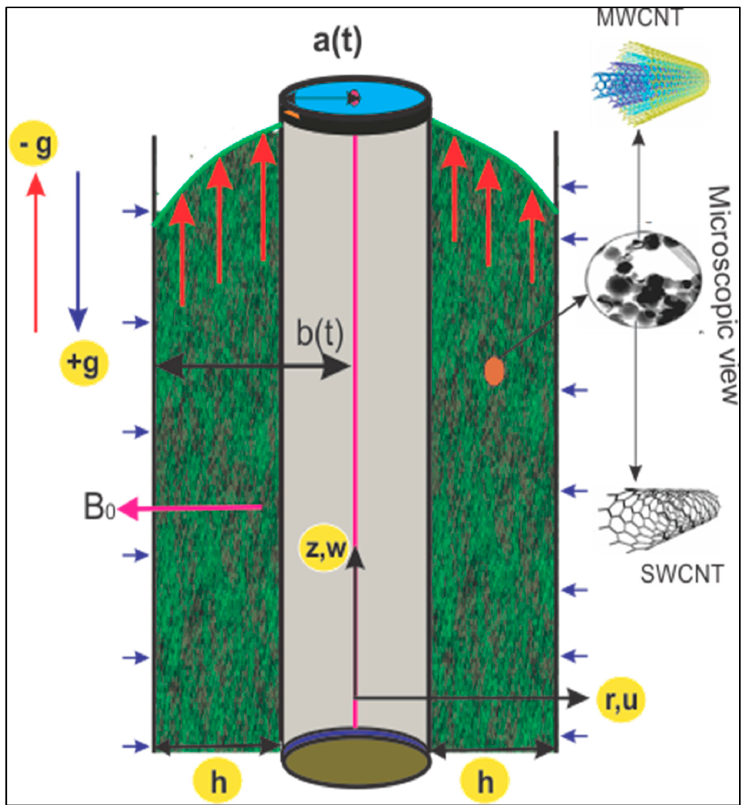
Figure 1. The geometry of the problem.